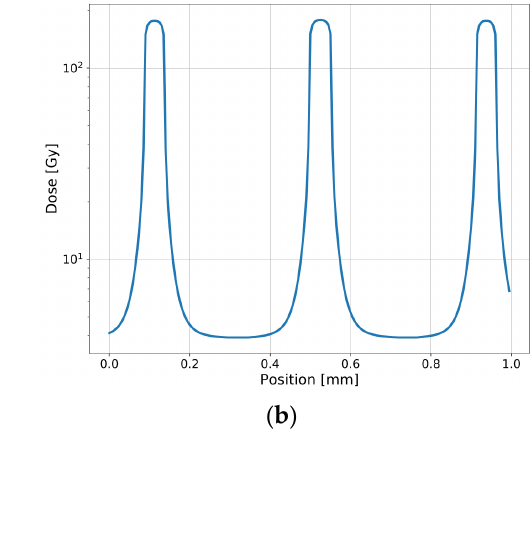
Figure 1. Scaled schematic of the dose distribution in a given target region seen in an upstream-to- downstream direction, shown for the monoplanar MBI with 50 µ m wide microbeams ( a ) and PBI generated with the same multislit collimator used for the monoplanar MBI and additional horizontal fractionation, resulting in a grid of 50 µ m × 50 µ m pencilbeams ( b ). The centre-to-centre distance is 400 µ m for both MBI and PBI.